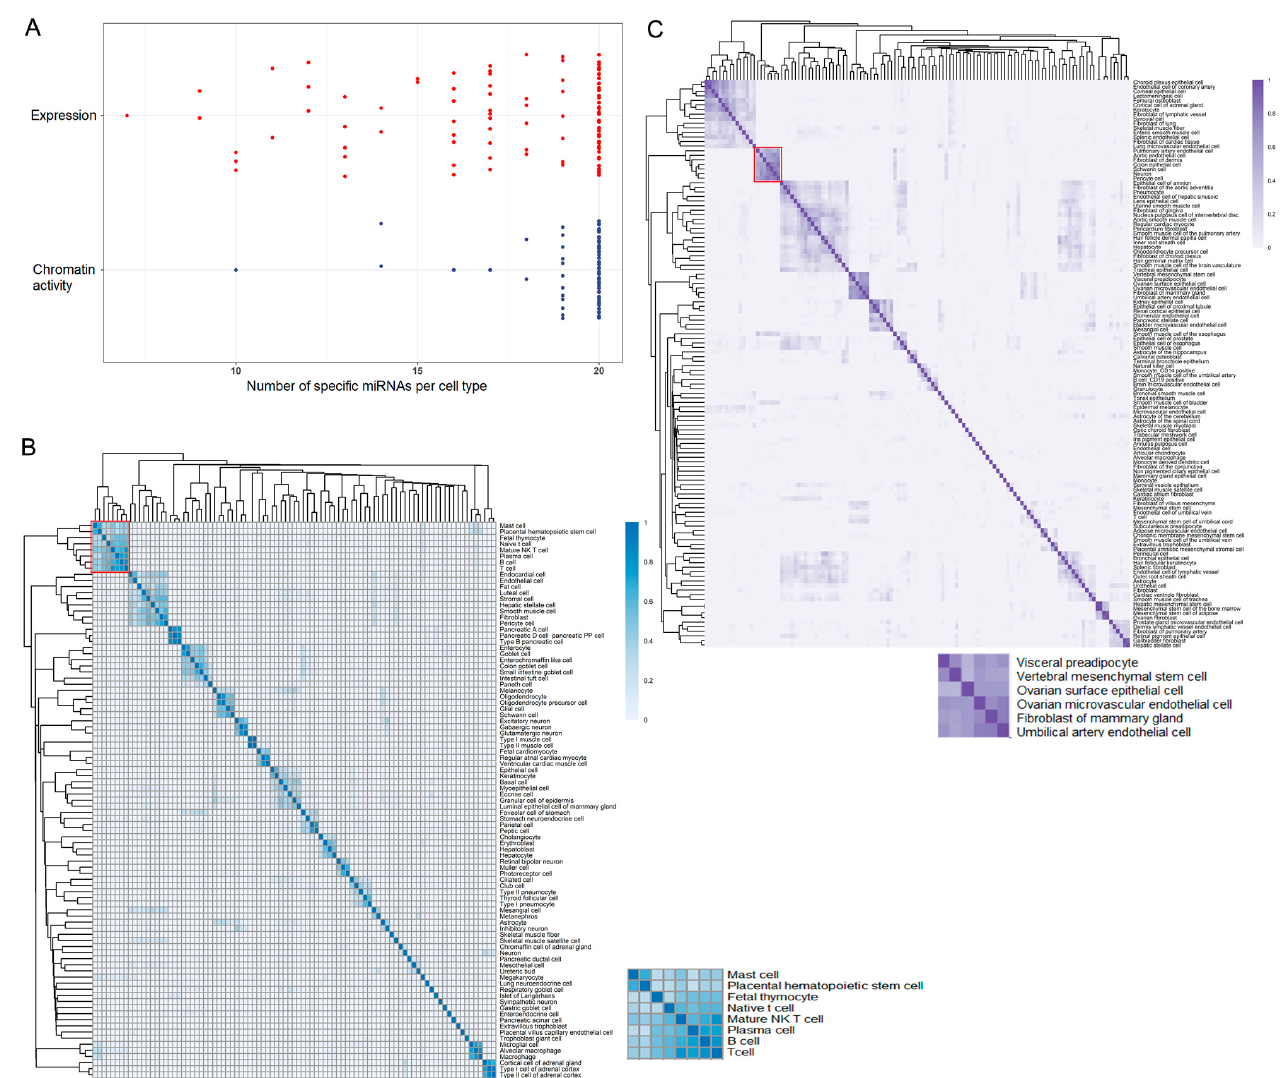
Figure 1. Overview of the cell-type-specific miRNA catalogs. ( A ) Jitter plot showing the number of miRNAs per cell type in the catalog of cell-type-specific miRNAs. ( B ) Clustering heatmap showing the similarities (measured by the Jaccard index) between 91 cell-type-specific chromatin activity miRNA sets. ( C ) Clustering heatmap showing similarities (measured by Jaccard index) between 124 cell-type-specific expression miRNA sets. The 2 representative dense clusters of cell types are highlighted by the red boxes.